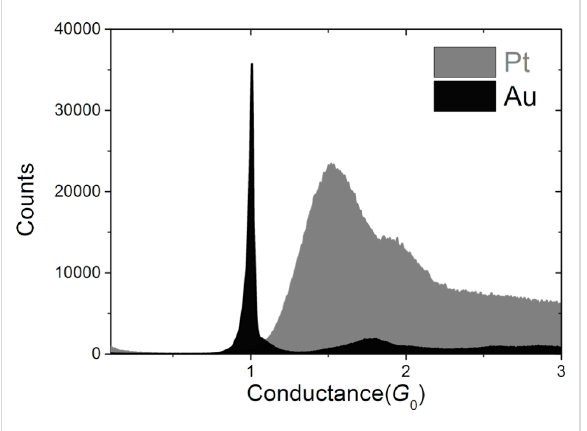
Figure 2: Histograms of conductance values for Au and Pt collected from 20000 individual breaking traces.